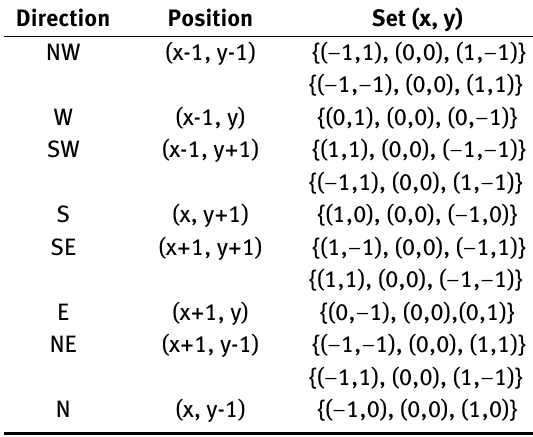
Table 1: Pixels used for calculating the fuzzy differential in every direction Direction